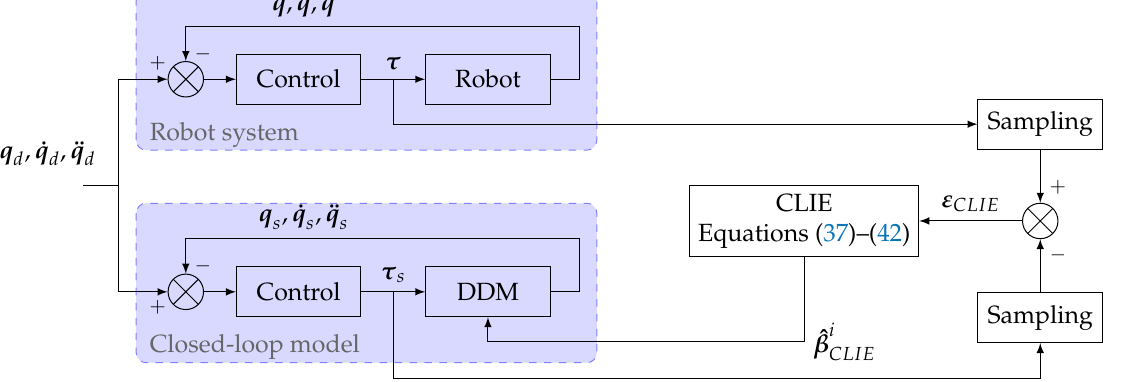
Figure 3. Block diagram of the Closed-Loop Input Error (CLIE) identification